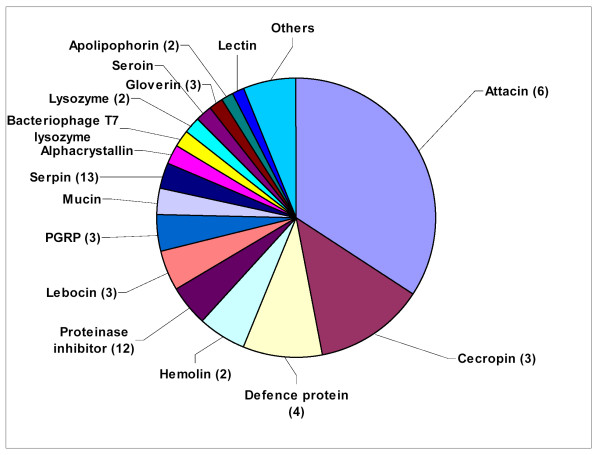
Distribution of immune-related transcripts in A. mylitta fat body transcriptome. The figure in parenthesis indicates the number of isoforms identified in that particular gene family.